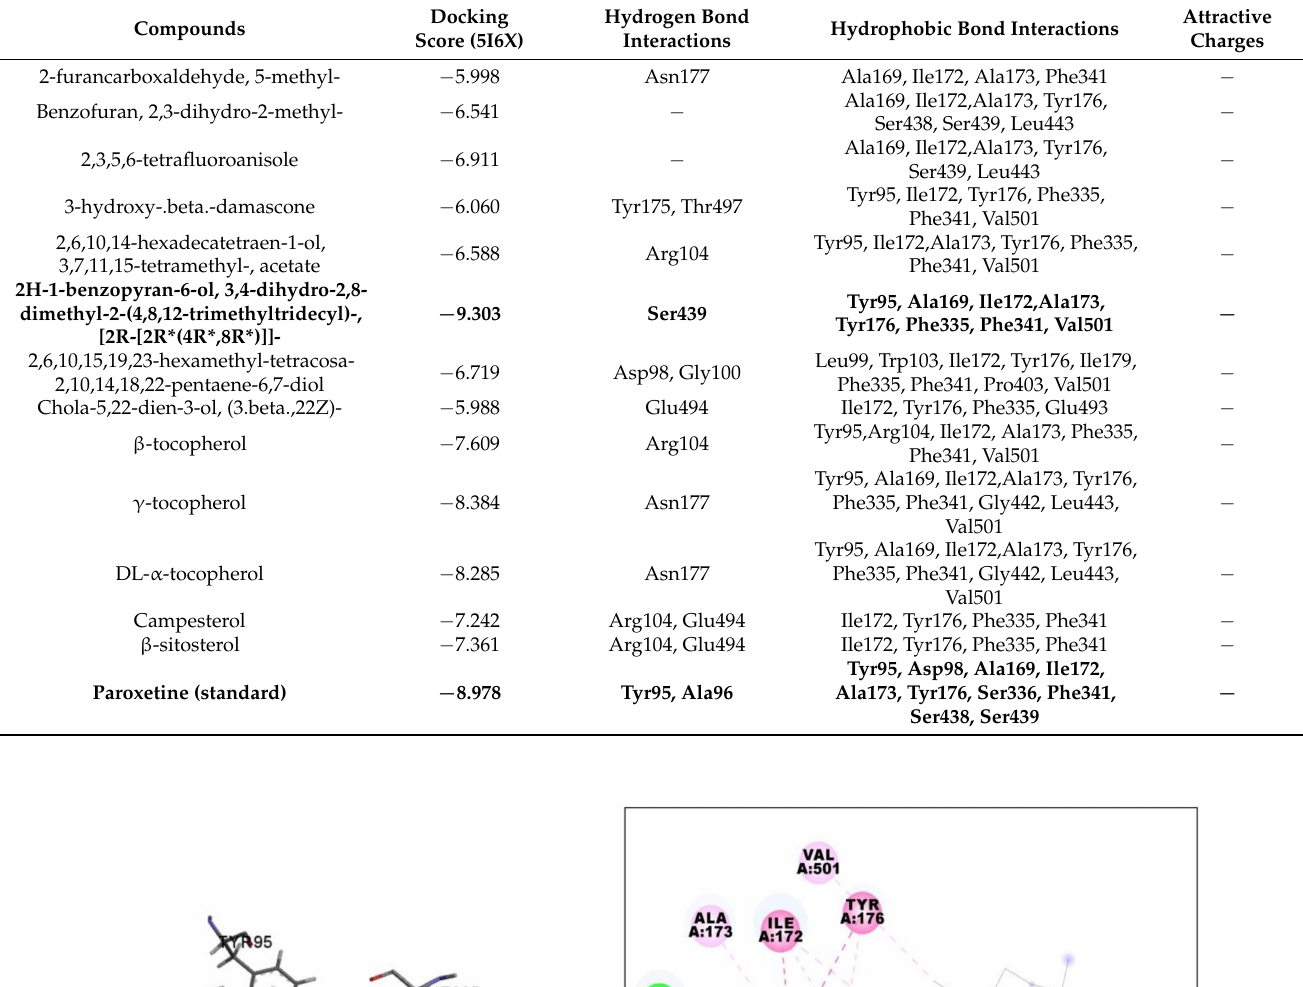
Table 4. Docking scores for selected compounds identified in the methanol extract of Cnesmone javanica with human serotonin receptor (PDB ID: 5I6X). Bold text indicates the best scores. Docking Hydrogen Bond Compounds Hydrophobic Bond Interactions Score (5I6X) Interactions